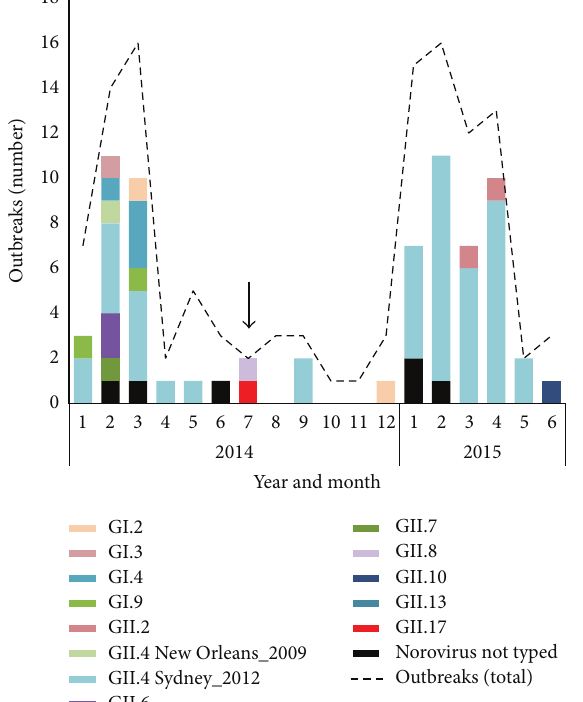
Figure 1: Distribution of norovirus genotype in Nova Scotia from January 2014 to June 2015. The total number of viral enteric outbreaks is indicated by a dashed line. The arrow represents the appearance of norovirus genotype GII.P17-GII.17.